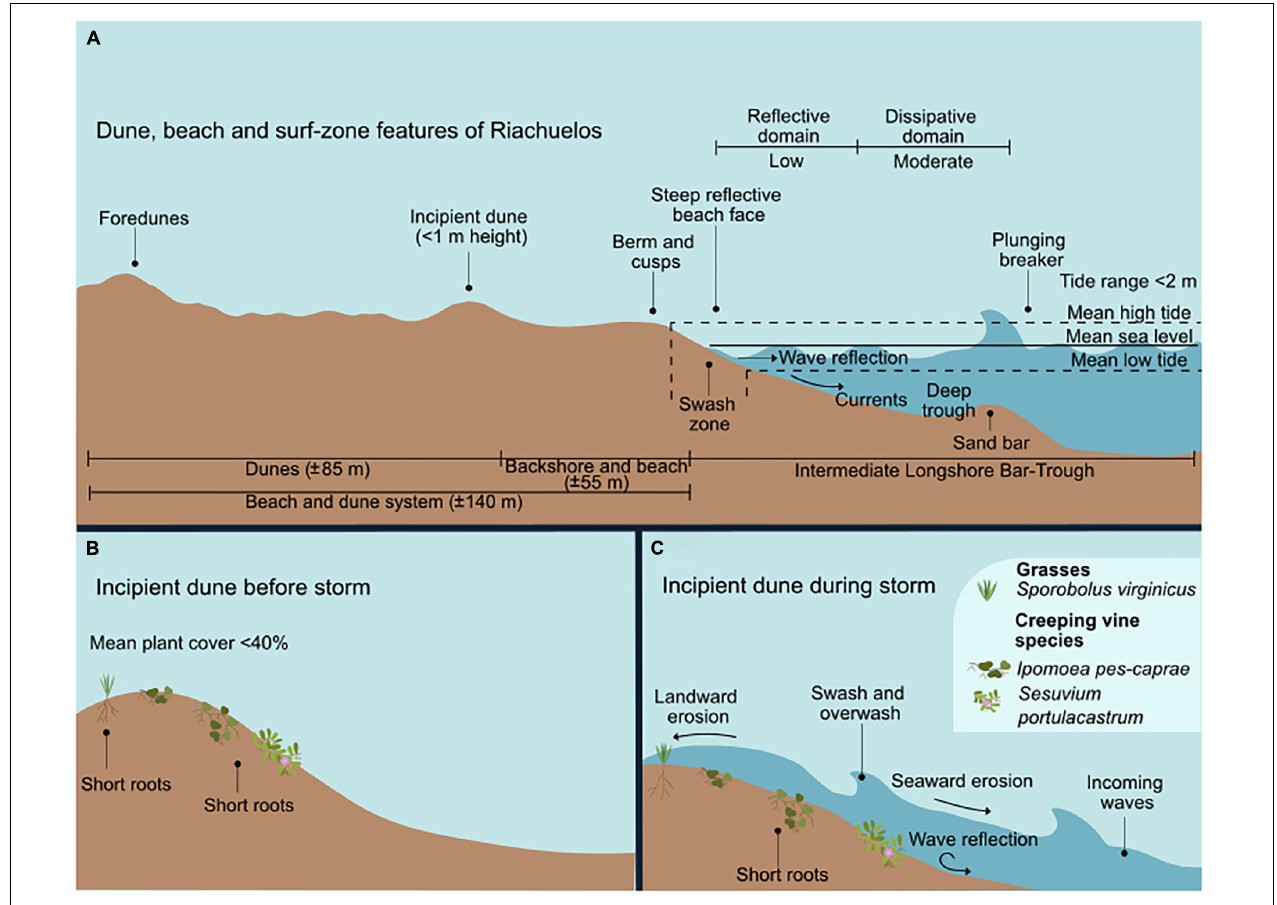
FIGURE 4 | The surf-zone and dunes of Riachuelos. (A) Dune, beach, and surf-zone features. (B) The incipient dunes and species before the storm. (C) The incipient dune during the storm, showing the wave-induced erosion.